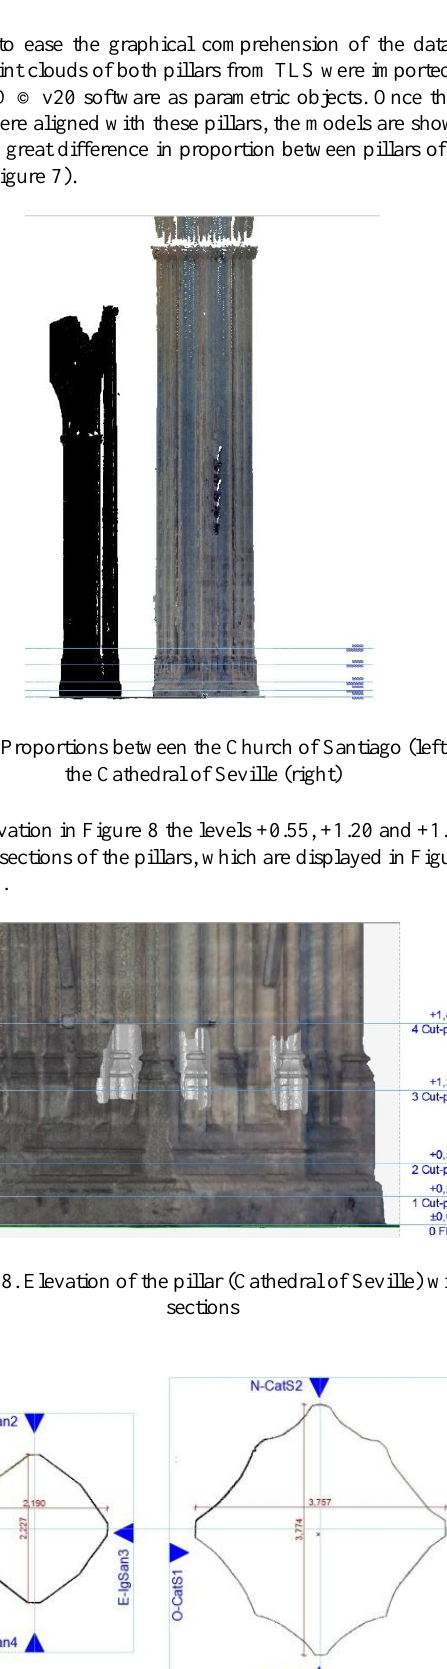
Figure 6. Sections in meshes